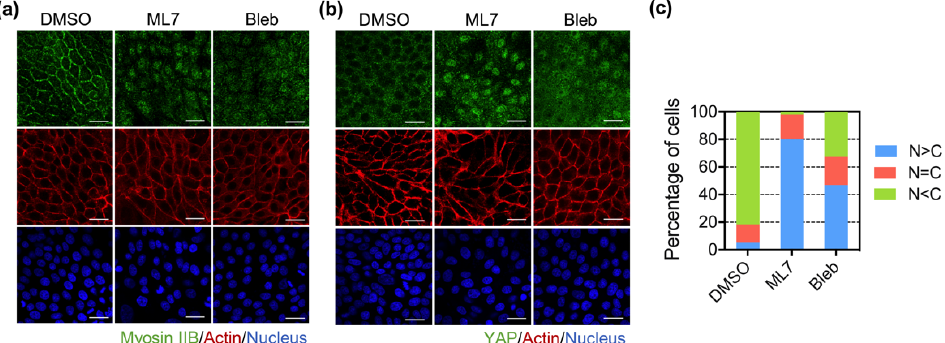
Figure 2. Inhibition of junctional myosin IIB promoted YAP nuclear retention. MK4 cells at the overconfluent stage were treated with the indicated inhibitors for 24 h. The inhibitors included ML7 (25 µ M, myosin light-chain kinase inhibitor) and blebbistatin (Bleb, 50 µ M, myosin II heavy-chain inhibitor), dimethyl sulfoxide (DMSO) was used as control: ( a ) Representative confocal immunofluorescence images of MK4 cells at the confluent stage, which were stained with myosin IIB (green), Phalloidin (red), and Hoechst 33,258 (blue). Scale bar = 20 µ m; ( b ) Representative confocal immunofluorescence images of MK4 cells at the confluent stage, which were stained with YAP (green), Phalloidin (red), and Hoechst 33,258 (blue). Scale bar = 20 µ m; ( c ) Percentage of cells with predominant nuclear YAP localization (N > C), equal nuclear and cytosol YAP localization (N = C), and predominant cytosol YAP localization (N < C).